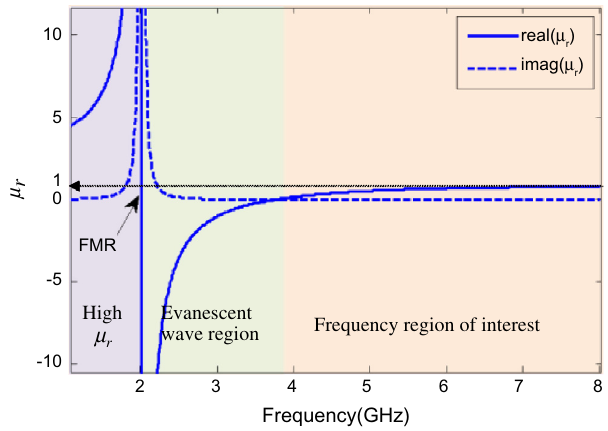
Figure 11. Relative permeability, l r of YIG substrate biased with H ext = 2500 Oe along its smallest dimension. Above 3.7 GHz, l r becomes positive again and allows for tunable operation at X -band controlled by the internal bias field H 0